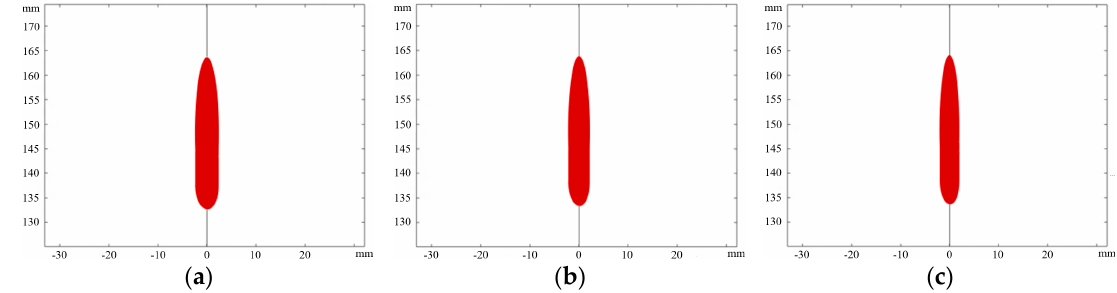
Figure 6. Simulated BFRs of bovine liver after ultrasonication with di ff erent combinations of acous-